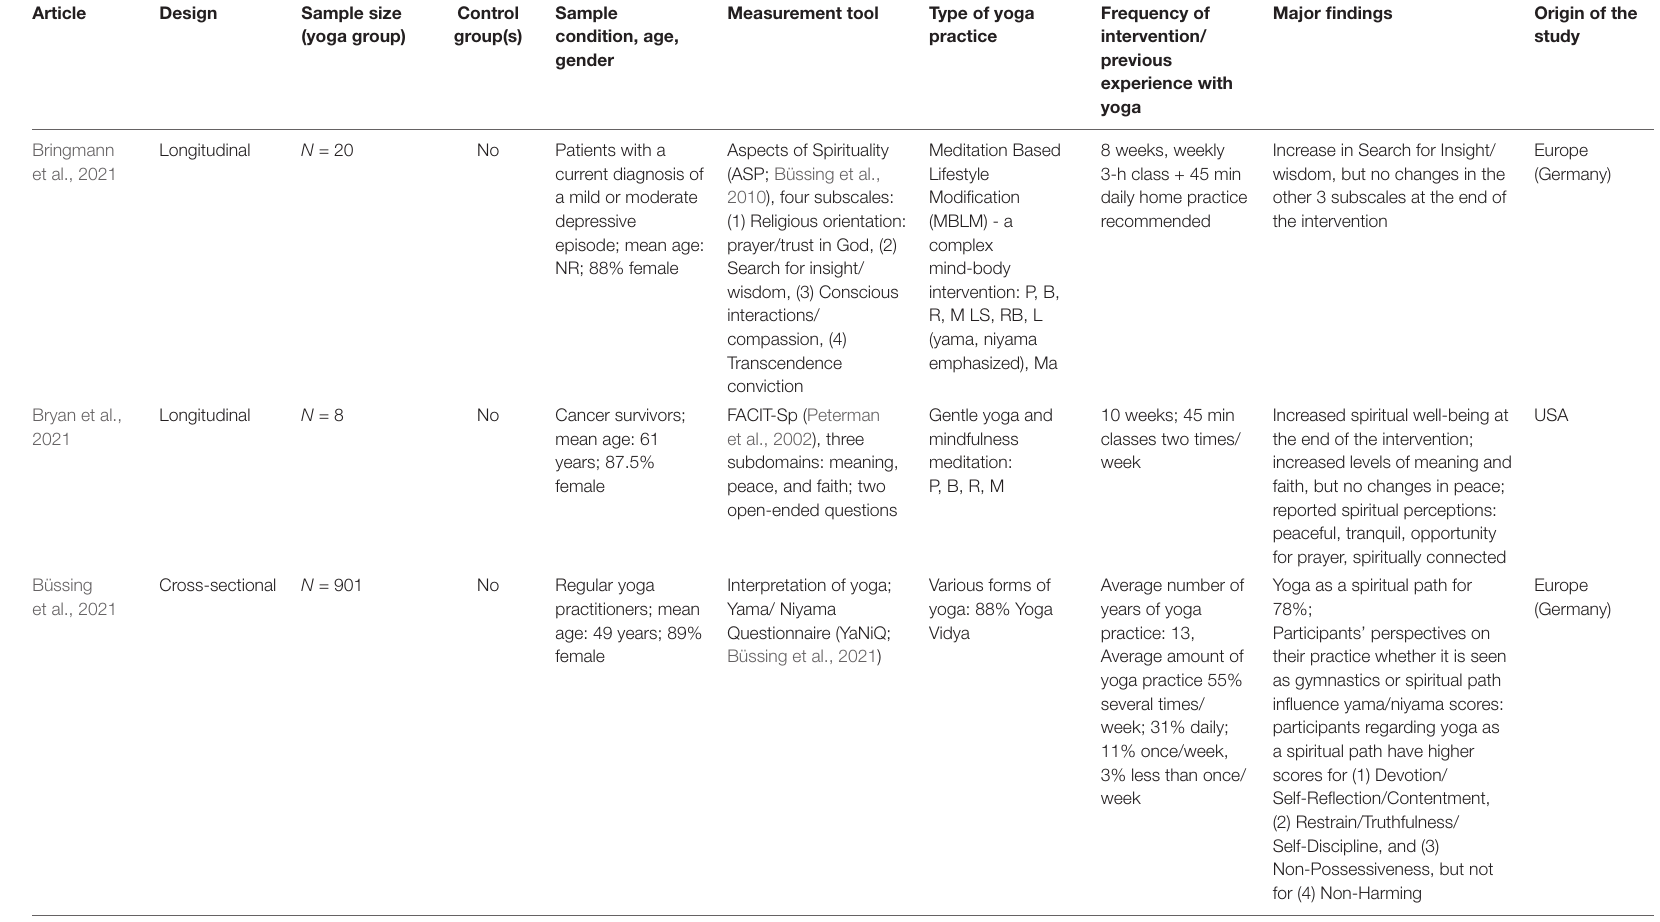
TABLE 2 | Summary of the articles between 2020 and 2021 (all with quantitative